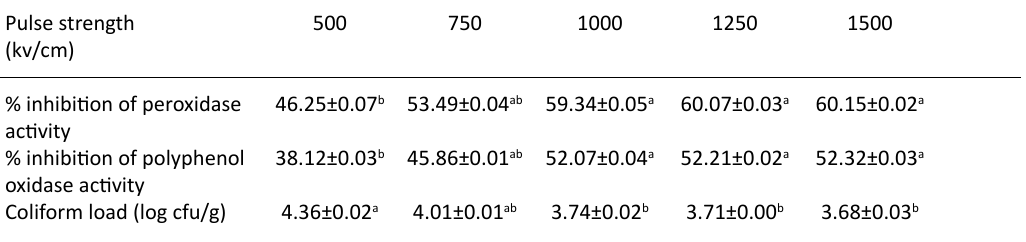
table 1. Impact of pulse strength (kV/cm) of PEF ahead-treatment to enzymatic and microbial inactivation in flower Pulse strength